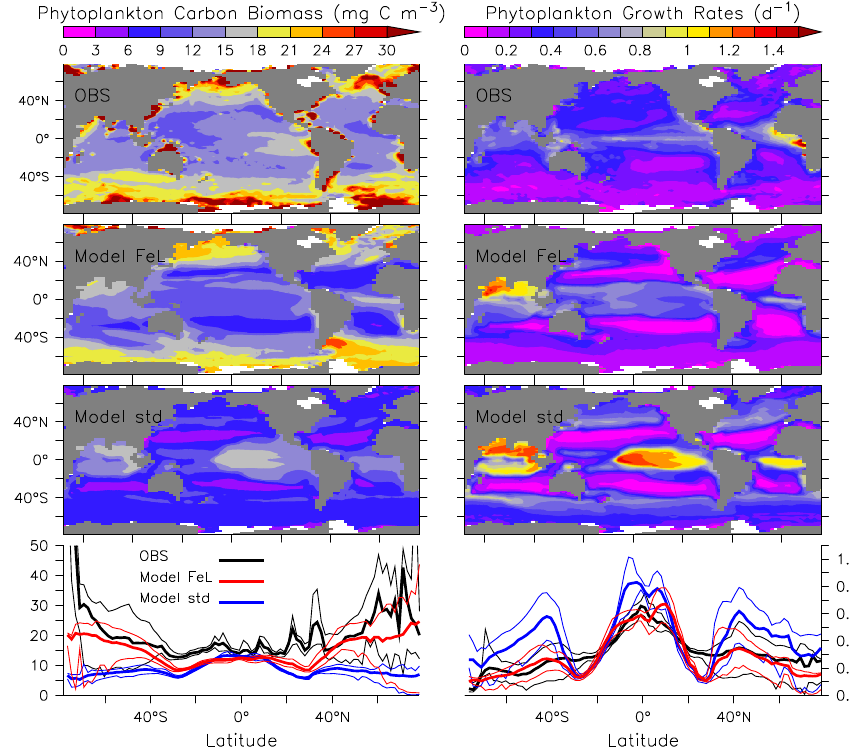
Fig. 1. Annual mean surface (0–50m) phytoplankton carbon biomass (left) and growth rates (right) from satellite estimates (top, Westberry et al., 2008) and two models. Model FeL uses temperature-dependent zooplankton growth rates ( Q 10 = 1 . 9, g ( T = 0 ◦ C ) = 0 . 6d − 1 ) and a simple parameterization of iron limitation of phytoplankton growth rates similar to that used by Somes et al. (2010), which modulates maximum phytoplankton growth rates by aeolian iron flux (Mahowald et al., 2005). Whereas Somes et al. (2010) used iron limitation only for diazotrophs, here we also apply it to other phytoplankton. Whereas non-diazotroph phytoplankton’s growth rates are linearly reduced by up to 60% for iron fluxes less than 1gm − 2 yr − 1 , diazotroph’s growth rates are reduced by up to 80%, accounting for their higher iron requirements. Model std uses no temperature dependence of zooplankton growth rates and no parameterization of iron limitation. Bottom panels show zonally averaged values (thick lines), including the annual minimum and maximum (thin lines) to indicate the amplitude of the seasonal cycle. Annual averages have been calculated using monthly model output only at those grid points where observations are available for that month. At high latitudes the satellite data are biased toward summer. Maximum zooplankton growth rates of model FeL are consistent with results from incubation experiments (Hansen and Jensen,